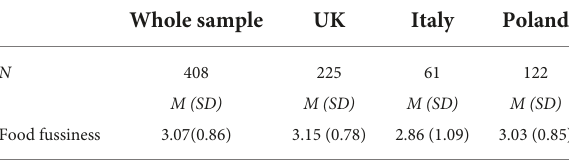
TABLE 9 Food fussiness (CEBQ:FF) scores for the children in the UK, Italy, and Poland. Whole sample